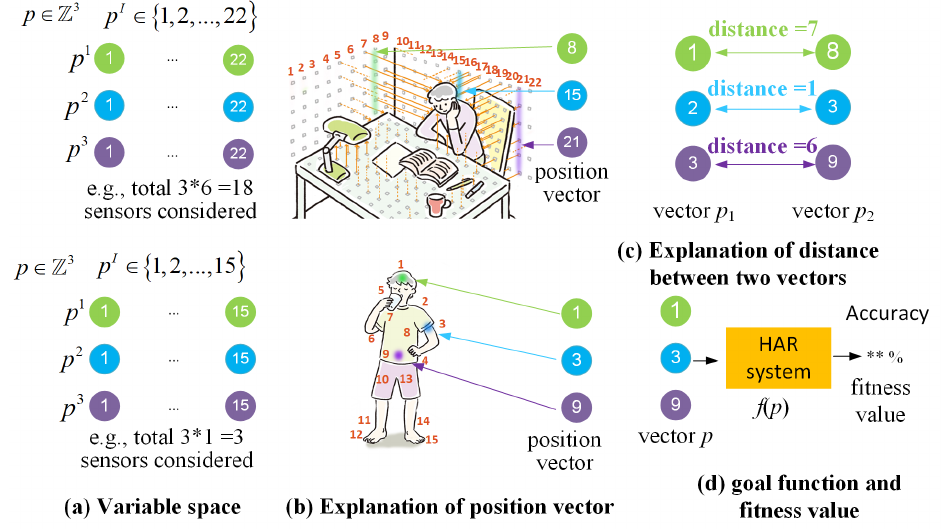
Figure 3. ( a ) is the variable space. For example, the position vector has three dimensions, i.e., I ∈ { 1,2,3 } . Each dimension p I is in { 1,2,3 . . . ,22 } and { 1,2,3 . . . ,15 } for nonwearable and wearable, respectively; ( b ) is the illustration of a specific sensor number corresponding to the real sensor position; ( c ) defines the distance of each dimension between the two vectors; and ( d ) is the definition of the goal function and fitness